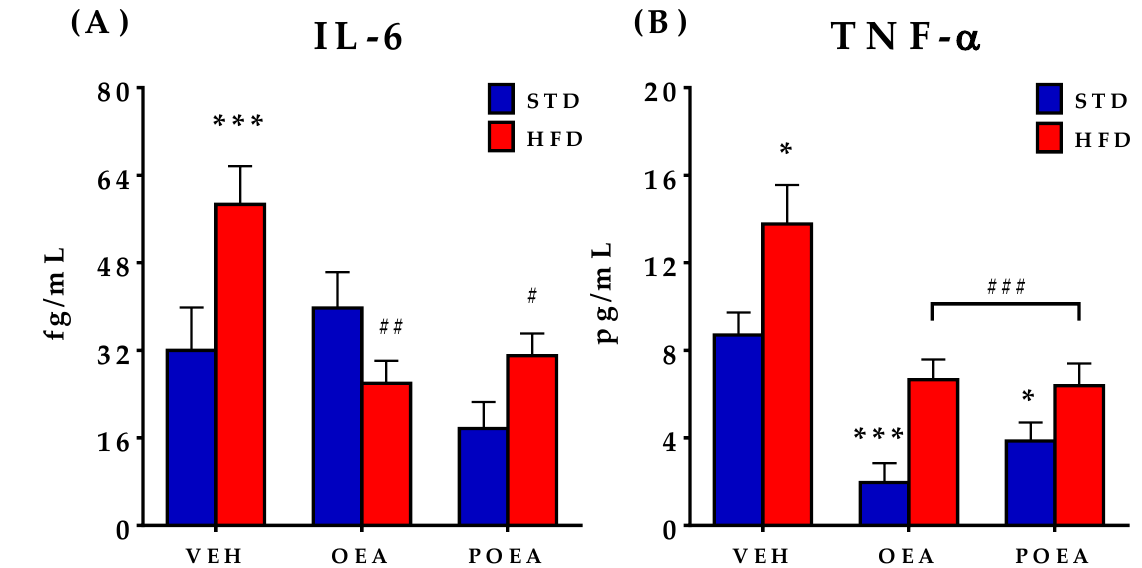
Figure 7. Effects of sub-chronic (15 days) administration of a 10 mg/kg dose of either oleoylethanolamide (OEA) or palmitoleylethanolamide (POEA) on the plasma levels of cytokines in male Sprague–Dawley rats: ( A ) Interleukin 6 (IL-6); and ( B ) tumor necrosis factor alpha (TNF- α ), which were evaluated at the end of the treatment. Values are presented as means ± standard error of the mean (SEM) ( n = 6–8 animals/group) analyzed by two-way ANOVA (diet and treatment and Bonferroni post hoc test). (*) p < 0.05 and (***) p < 0.001 significant differences compared with standard diet (STD) vehicle (VEH) group; (#) p < 0.05, (##) p < 0.01, and (###) p < 0.001 significant differences compared with hypercaloric cafeteria diet (HFD) VEH group.